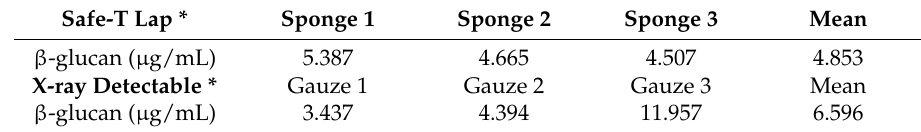
Table 1. In vitro quantification of (1 → 3)- β - D -glucan amount from surgical sponges and